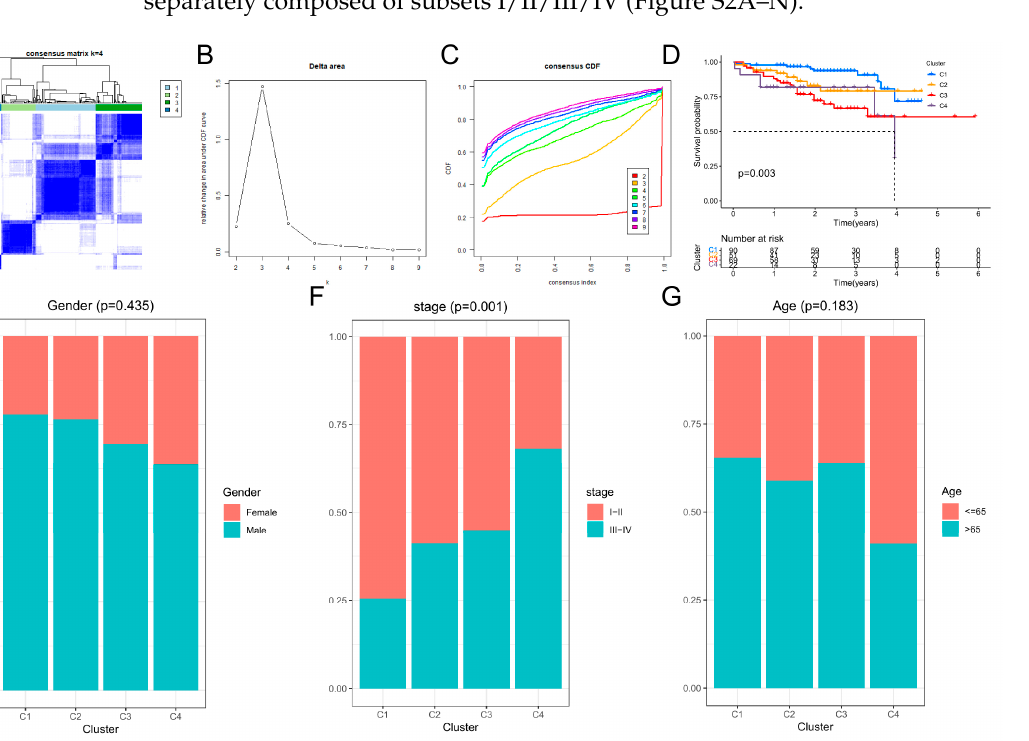
Figure 3. Four molecular subtypes of HCC in ICGC database based on differentiation-related genes. ( A – C ) Four molecular subtypes were identified at a clustering threshold of K = 9. ( D ) Kaplan–Meier analysis between the four molecular subtypes. ( E – G ) The proportion of clinicopathologic features among the four molecular